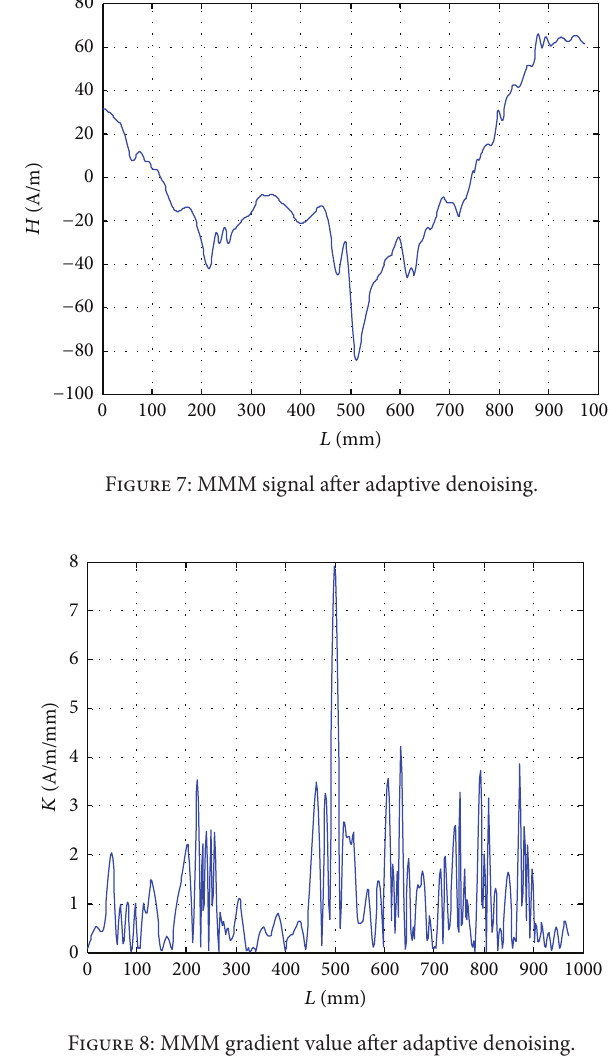
evaluation on service life of oil well casing for influence of noise is